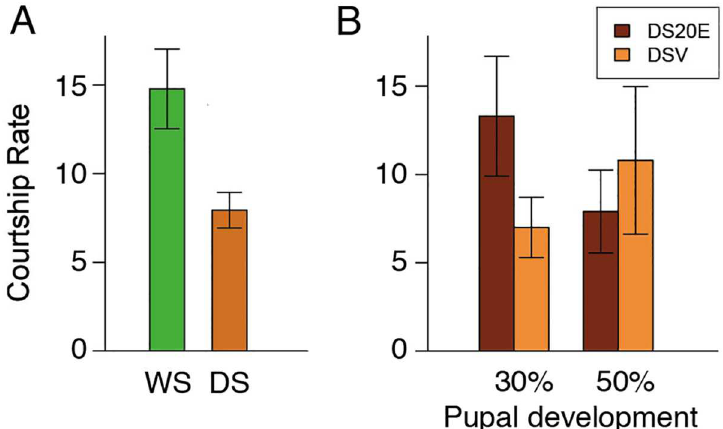
Fig 3. Raising 20E titers in DS males during pupal development significantly increasescourtship rate. A) Butterflies reared at the WS typical temperatureof 27˚C have a significantly highercourtship rate than butterflies reared at the DS typical temperature of 17˚C. B) Courtshiprate of DS males injected with 6000 pg of 20E at 30% of pupal development (30%P) is significantly higherthan the courtshiprate of DS males injectedwith vehicleat the same time. There is no significantdifference in the courtshiprate of DS males injectedwith 20E at 50% of development (50%P) comparedto DS males injectedwith vehicleat the same time (light brown). Error bars correspondto 95% confidenceintervals for the means.